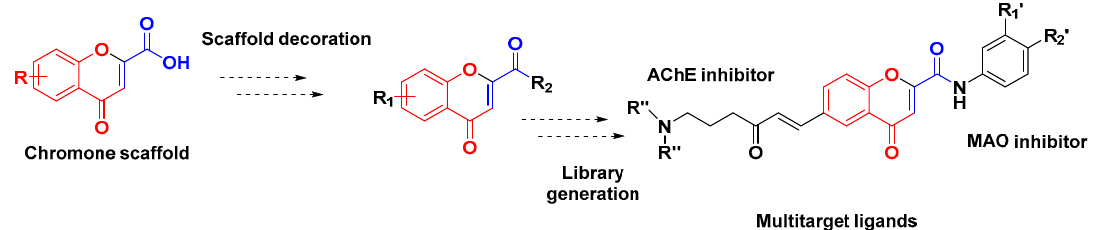
Figure 1. Drug design strategy followed to obtain multitarget ligands based on chromone scaffold.